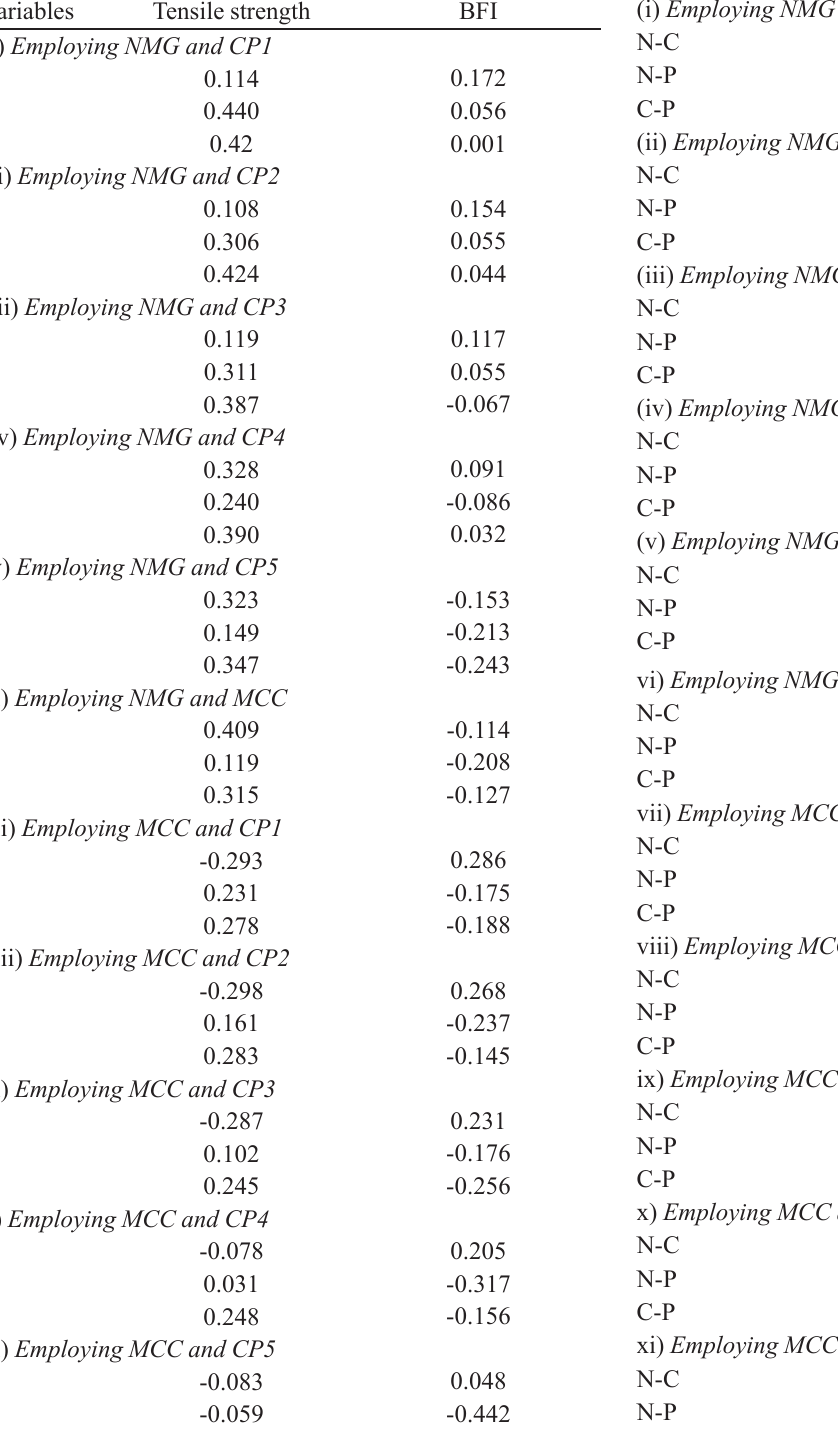
TABLE III - Quantitative effect of nature of binder (N), concentration of binder (C) and applied pressure (P) on the tensile strength and brittle fracture index values of paracetamol